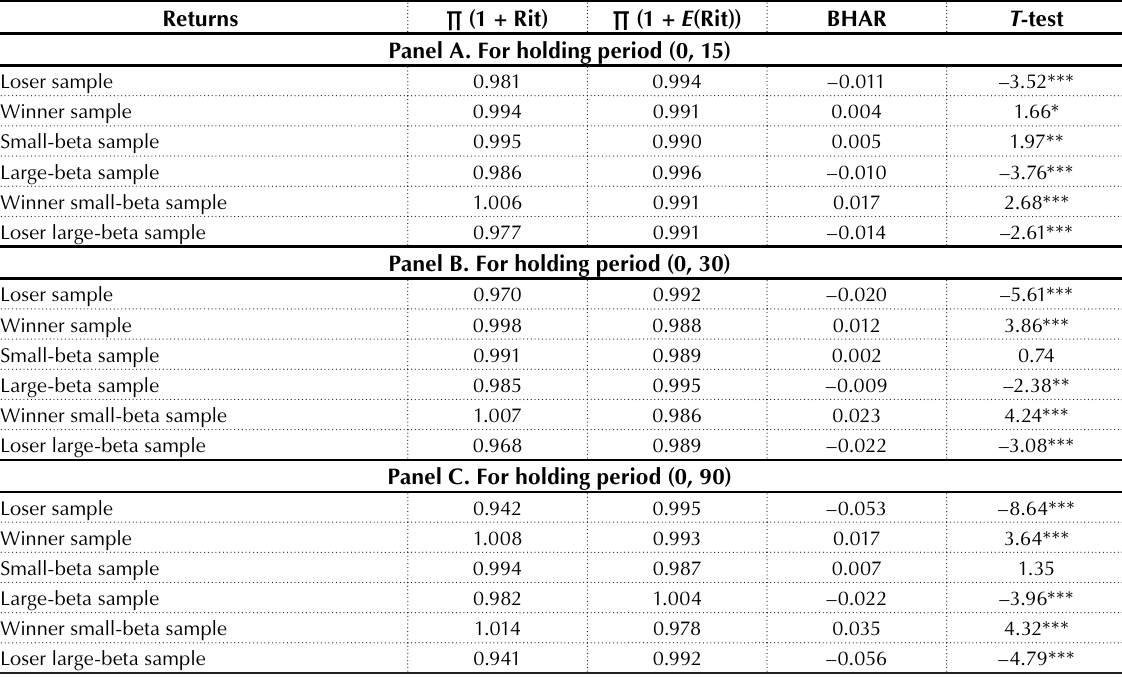
Table 6. Buy and hold abnormal returns (BHARs) after extreme market